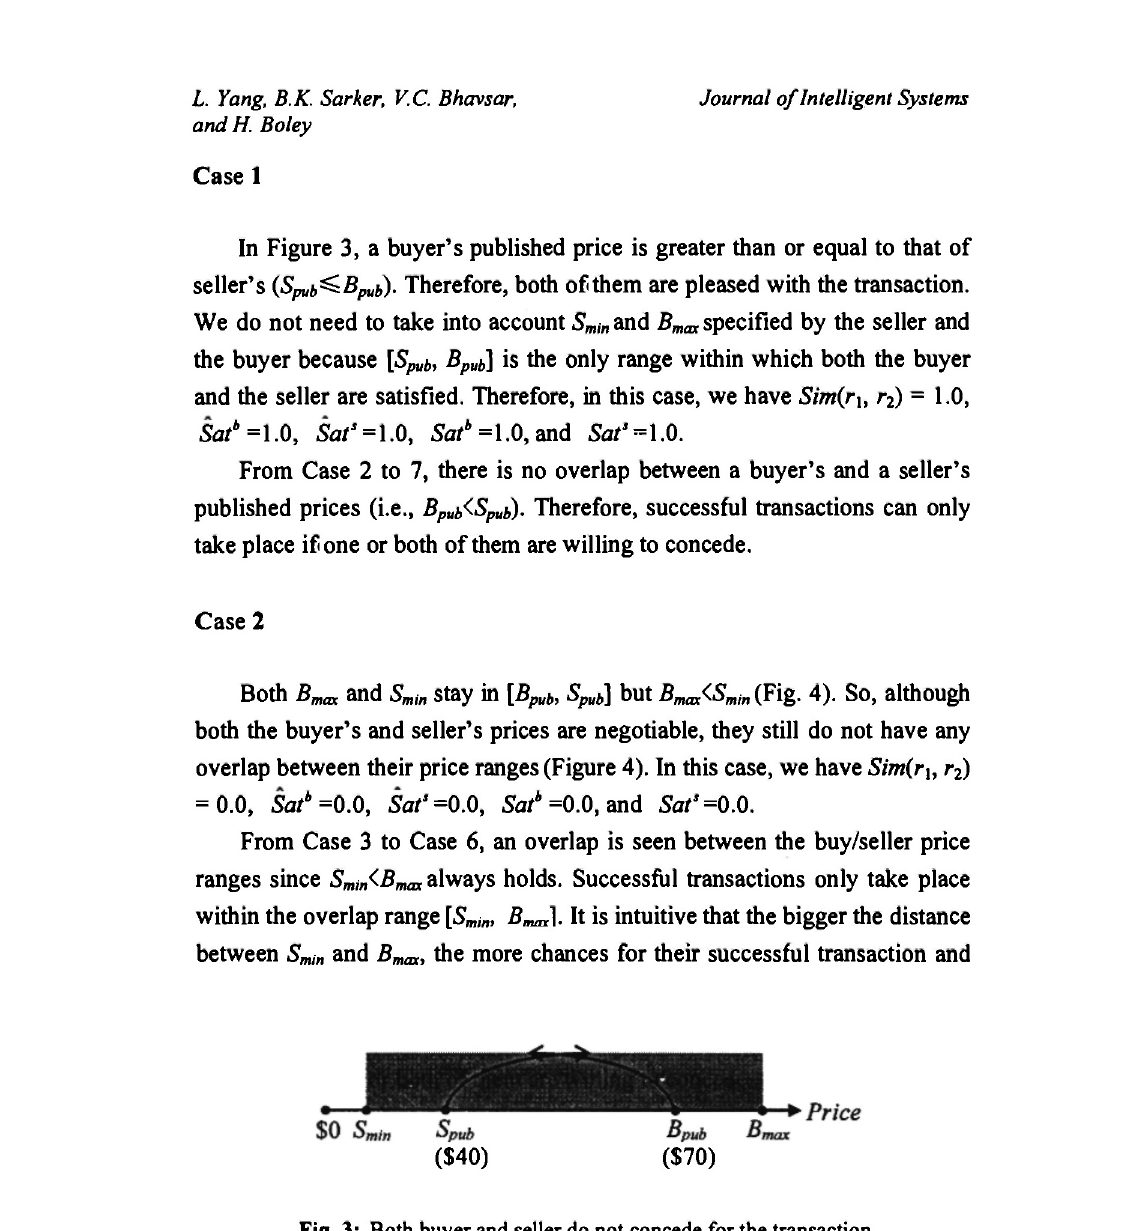
Fig. 3: Both buyer and seller do not concede for the transaction